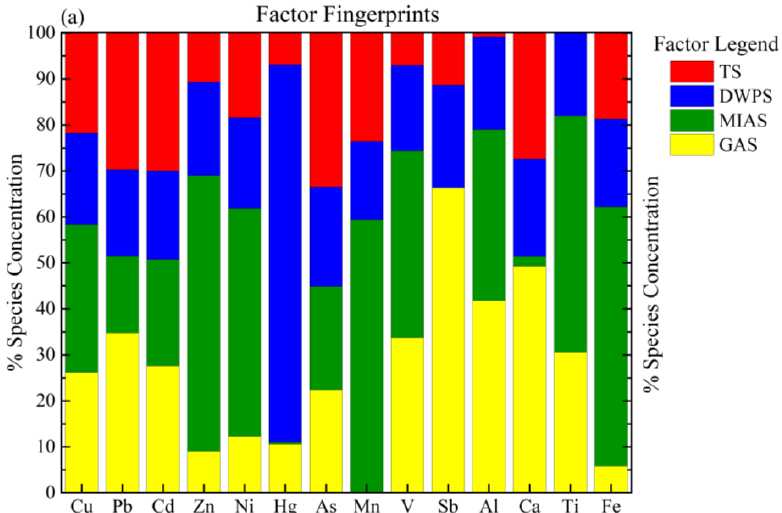
Figure 4. EF and Igeo index variation characteristics profiles in JDY and HH